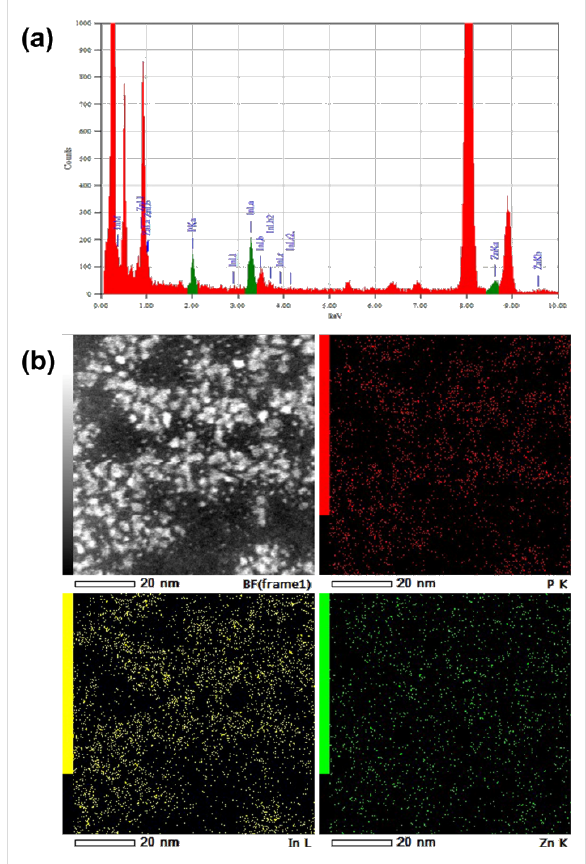
Figure 5: (a) EDX spectrum taken from the area of several tens of ODs; (b) HAADF-STEM image and elemental mapping of Zn/InP